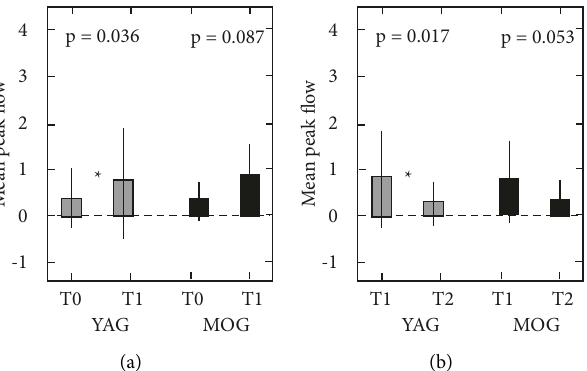
Figure 5: Mean peak flow measured in the superior orbicularis oris muscle. Numeric values are shown as the means ± SDs. ∗ p < 0 . 05 comparing (a) T 0 and T 1 and (b) T 1 and T 2. T 0, before the task; T 1, immediately after the task; T 2, five minutes after T 1; YAG, young adult group; MOG, middle-aged to old